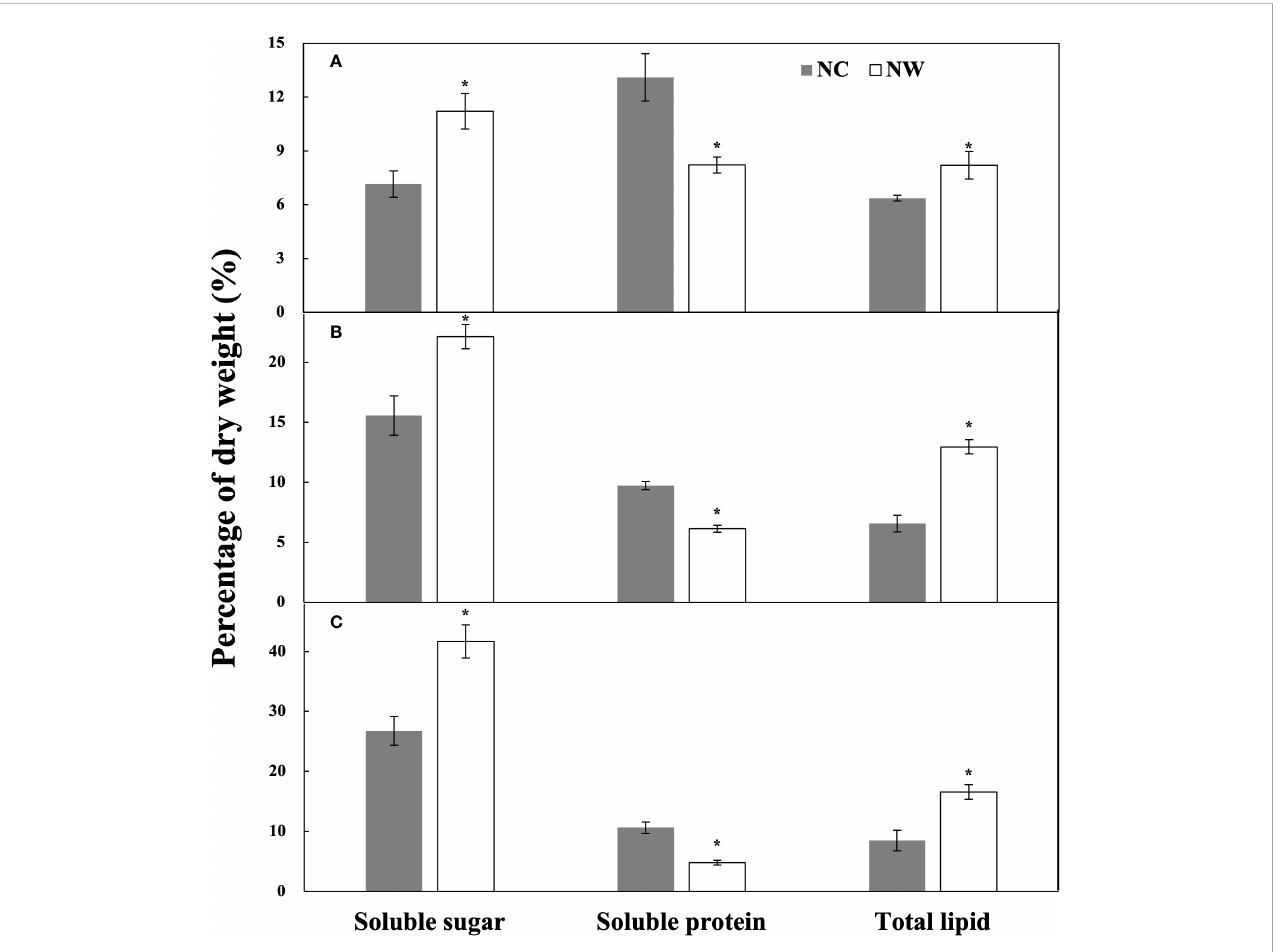
FIGURE 3 Contents of soluble sugar, soluble protein, and total lipid of N. oceanica (A) , C. atomus (B) , and C. weiss fl ogii (C) . NC, nitrate-N concentration of 13.85 mg·L – 1 . NW, nitrate-N concentration of 5 mg·L – 1 . The one-way ANOVA analysis and the Tukey ’ s post hoc test were executed to estimate the differences. “ * ” above the column indicates a signi fi cant difference ( P < 0.05) between NC and NW. Data are displayed as the mean ± SD (standard deviation) (n =